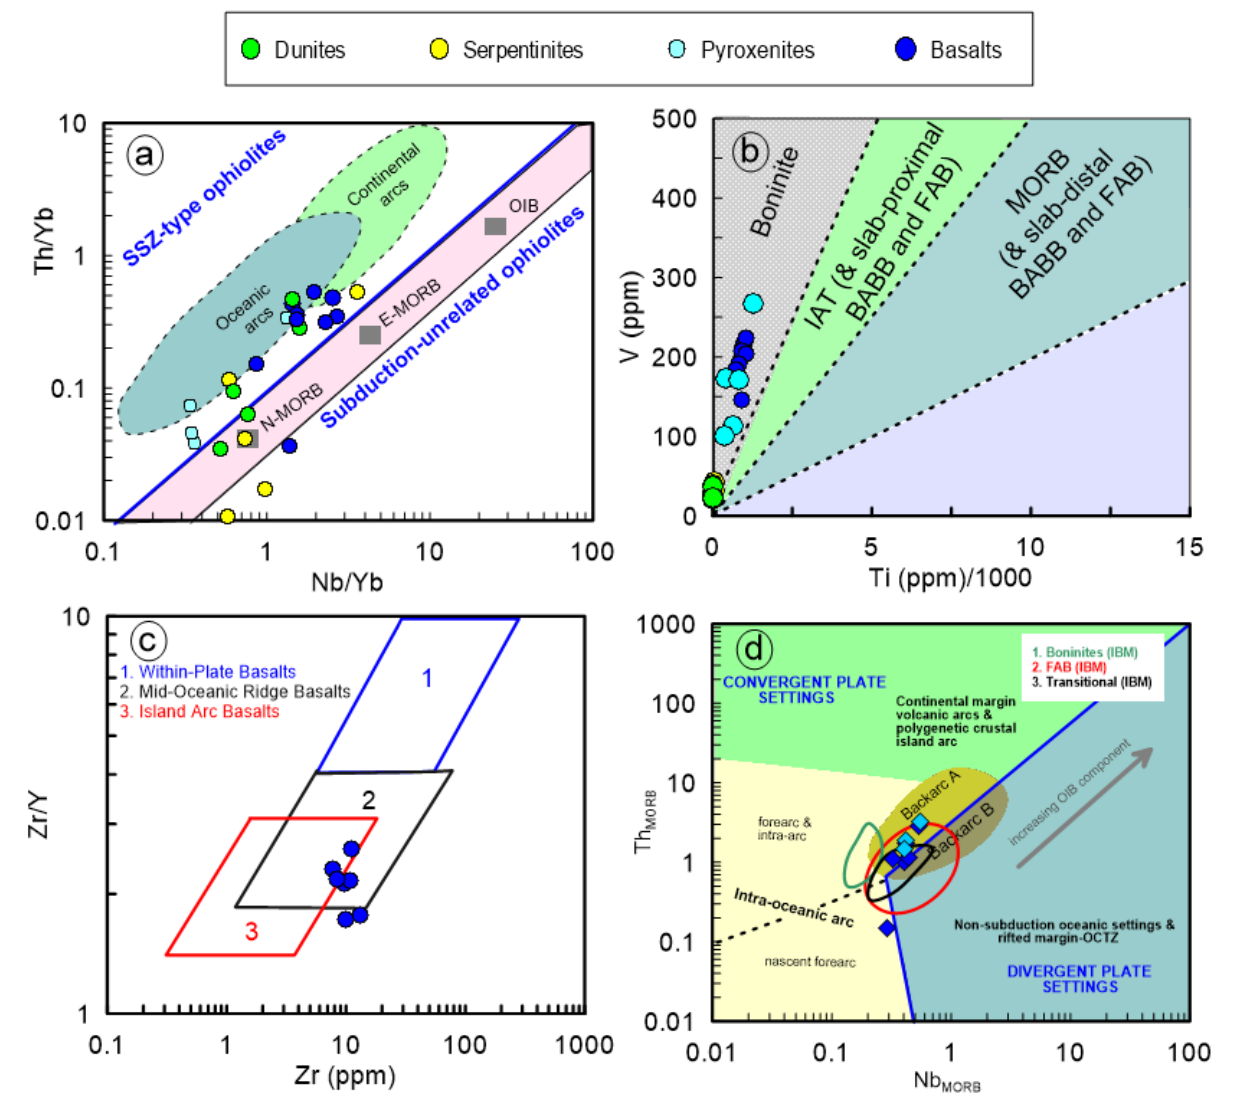
Figure 14. Tectonic discrimination diagrams. ( a ) Nb/Yb vs. Th/Yb plot [128,129] distinguishing suprasubduction zone (SSZ) ophiolites from mid-oceanic ridge ophiolites. Grey coloured rectangles represent average compositions of normal mid-ocean ridge basalt (N-MORB), enriched MORB (E-MORB), and ocean island basalt (OIB) on a MORB-OIB mantle array. The fields of continental arcs and oceanic arcs lie above the mantle array; ( b ) Ti/1000 vs. V plot [129,130] separating MORB, island arc tholeiite (IAT), and boninite magma types; ( c ) Zr vs. Zr/Y plot [131] showing the fields of within-plate basalts, MORB, and island arc basalts; ( d ) NbMORB vs. ThMORB plot showing tectonic interpretation for ophiolitic basaltic rocks [132,133]. Back-arc A represents immature intrao-ceanic or ensialic back-arc basin basalts (BABBs), whereas back-arc B indicates mature intra-oceanic BABBs. Fields of boninites, FAB IBM, and transitional basalts are from Reagan et al. [67]. MORB normalizing values are from Sun and McDonough [45].